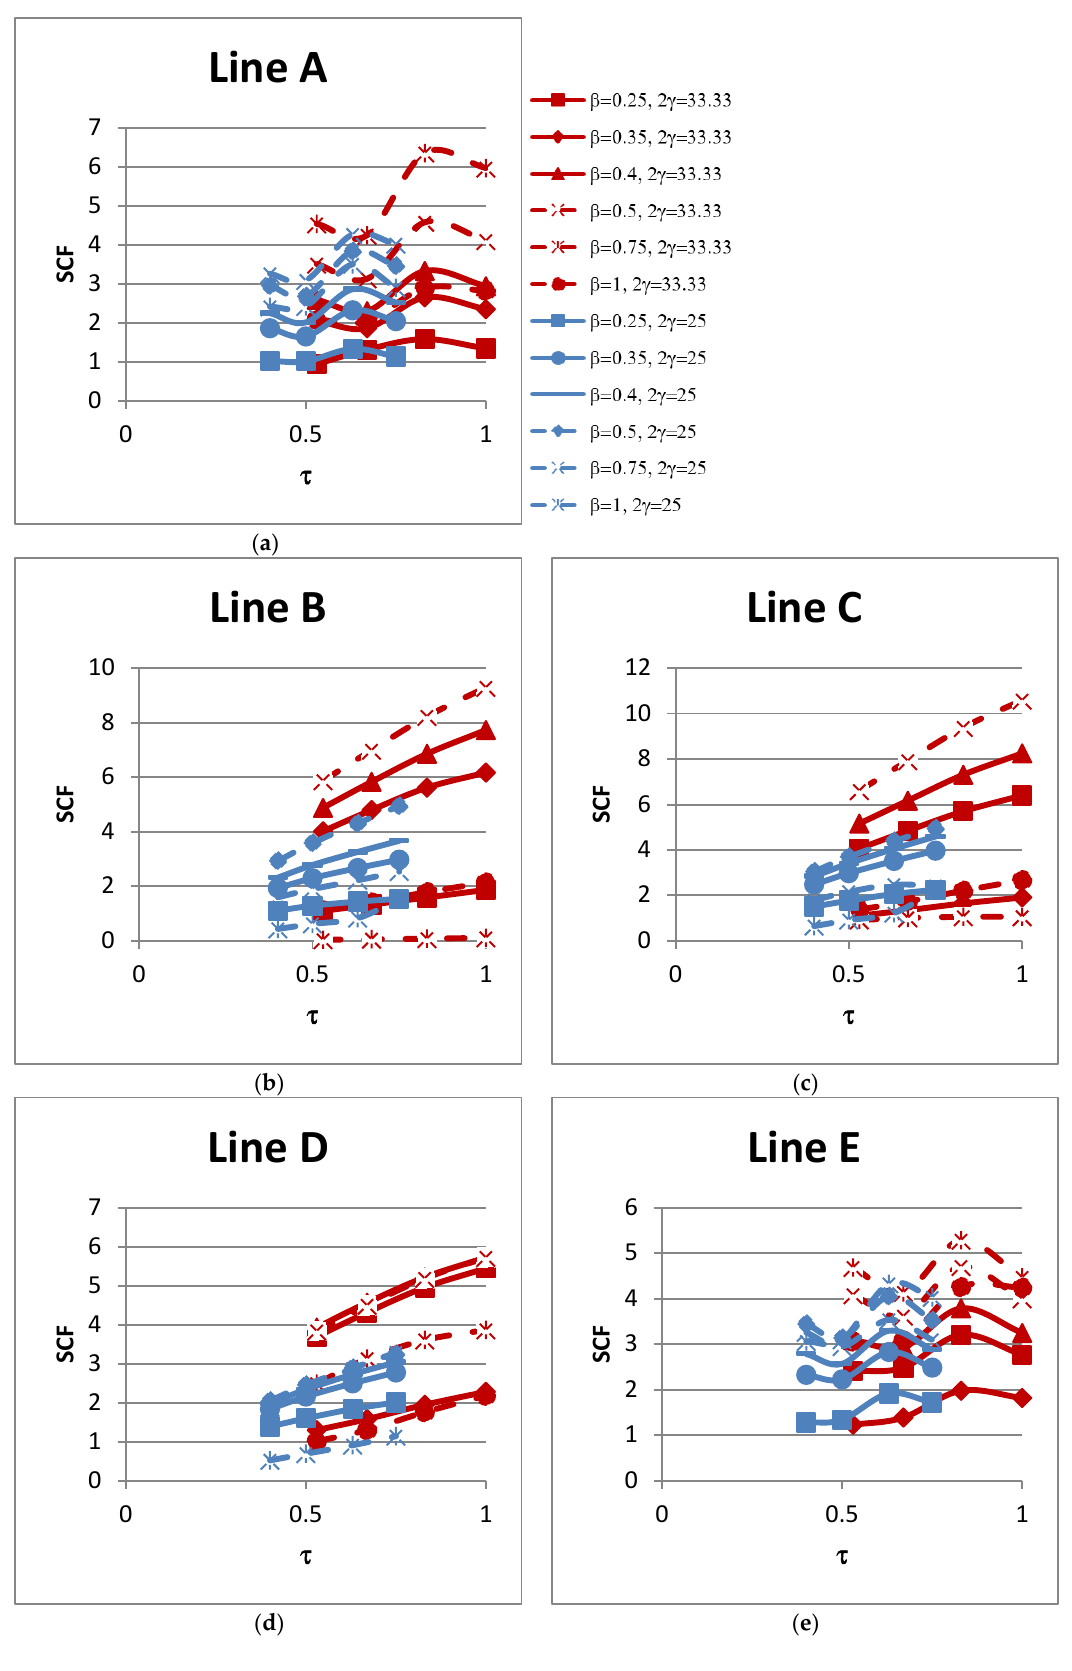
Figure 11. Influence of τ on SCFs along lines: ( a ) A; ( b ) B; ( c ) C; ( d ) D; and ( e ) E.